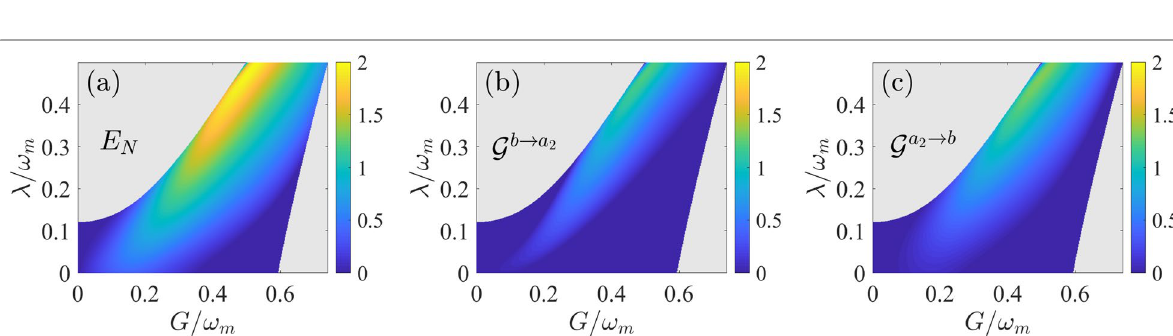
Fig. 3 The steady‑state population number of a the Bogoliubov mode a † a 1 versus the optomechanical coupling strength G and gain (cid:31) for J 1 (cid:31) (cid:30)